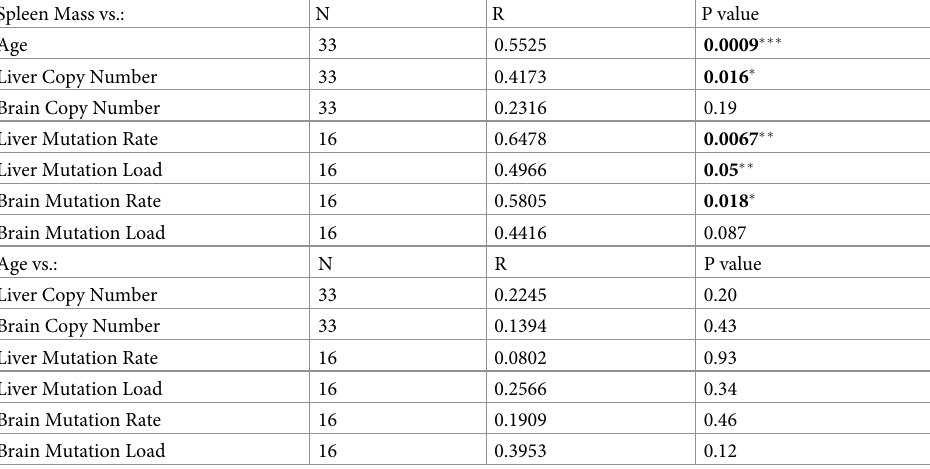
Table 1. Age and spleen mass correlations with mtDNA measures. A. Pearson’s correlations between spleen mass, age and mtDNA measures. B. Pearson’s correlations between age and mtDNA measures. Spleen Mass vs.: